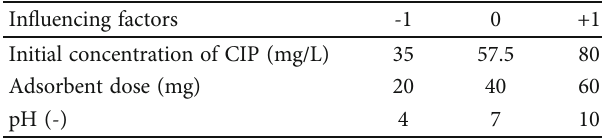
O ) nanoparticles using BBD. 3 4 Table 1: Selected levels of independent variables in